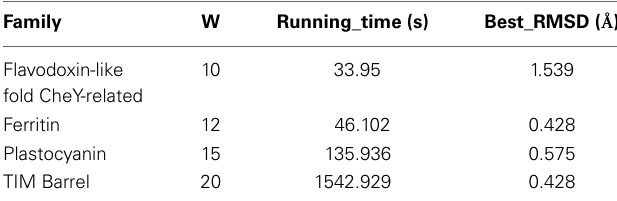
Table 2 | Running time and LRMSD of the best alignments on Skolnick’s dataset.